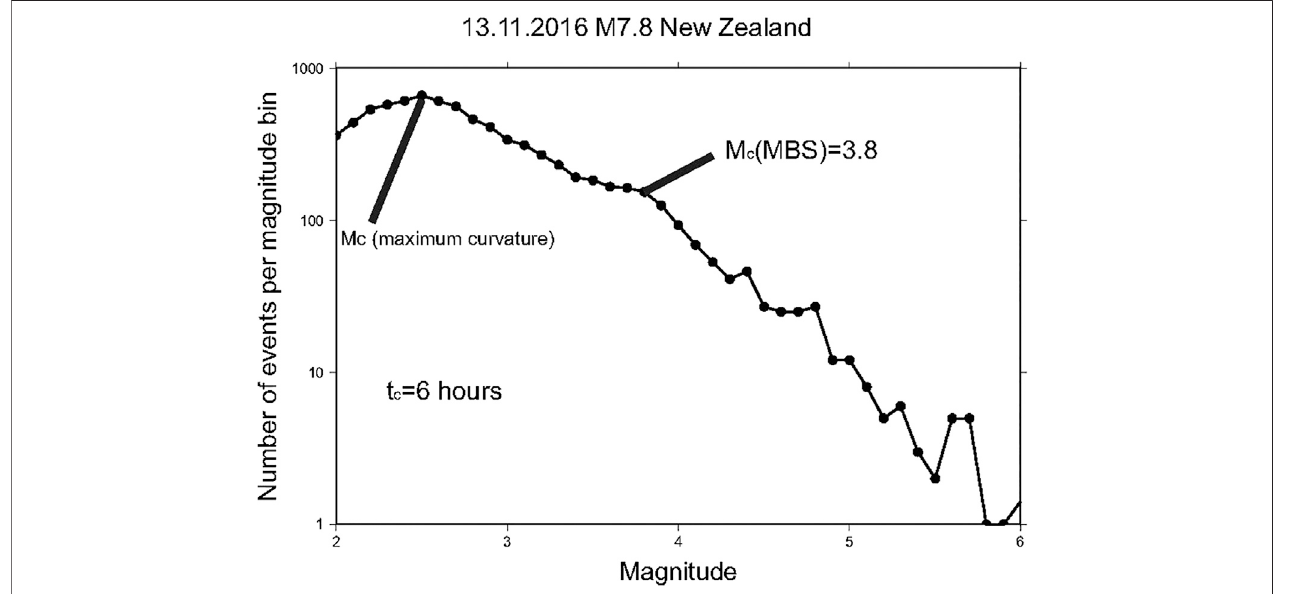
FIGURE2| DiagramofthemagnitudeofcompletenessM c usingdataintheinterval( t c ,1 month)afterthemainshock(NewZealand,M (cid:1) 7.8,November13,2016).